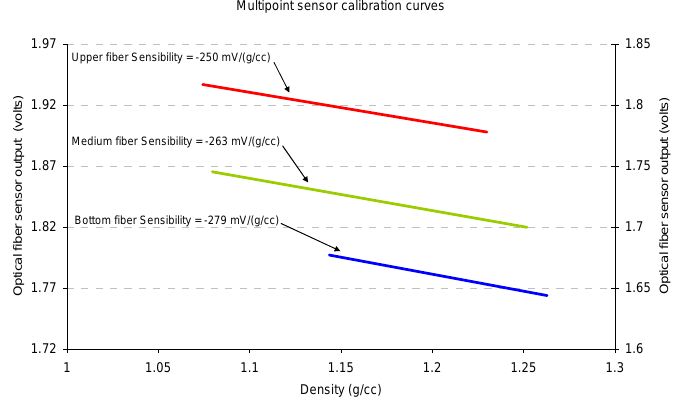
Figure 16. Calibration plot of the multipoint sensor in the bottom, medium and upper zones of the